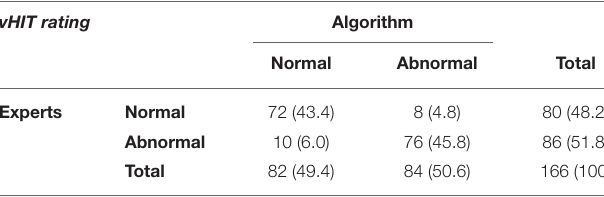
TABLE 2 | Cross table of algorithm’s and experts’ vHIT judgements with a modified VOR gain cutoff at